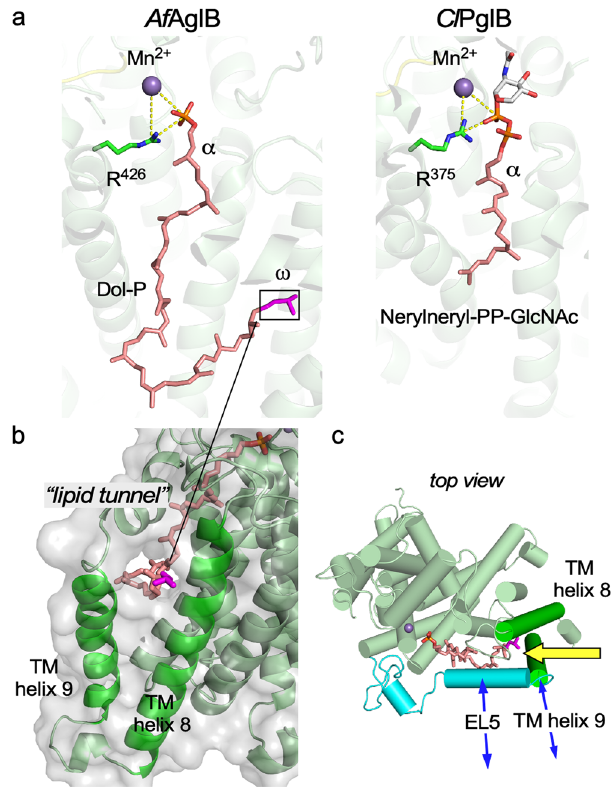
Fig. 5 Interactions between Af AglB and bound dolichol-phosphate. a Dolichol-phosphate molecule bound to Af AglB and Cl LLO analog bound to Cl PglB (PDB: 6GXC). The tripartite relationships between the metal ions (purple spheres), conserved arginine residues (green sticks), and phosphate groups that directly bind to the reducing-end monosaccharide residues (orange and red sticks) are highlighted by the yellow dashed lines. b Lipid tunnel structure formed between TM helices 8 and 9. The ω - terminal isoprene unit is magenta. c Top view of the N-terminal TM region. The C-terminal globular domain is not displayed for clarity. TM helices 8 and 9 and two α -helices in the EL5 loop are depicted as green and cyan cylinders, respectively. The yellow arrow indicates the putative entry route of the Af LLO molecule into the binding site. The blue arrows indicate the motions between the closed (ordered) and open (disordered) states of TM helix 9 and the N-terminal half of the EL5 loop.